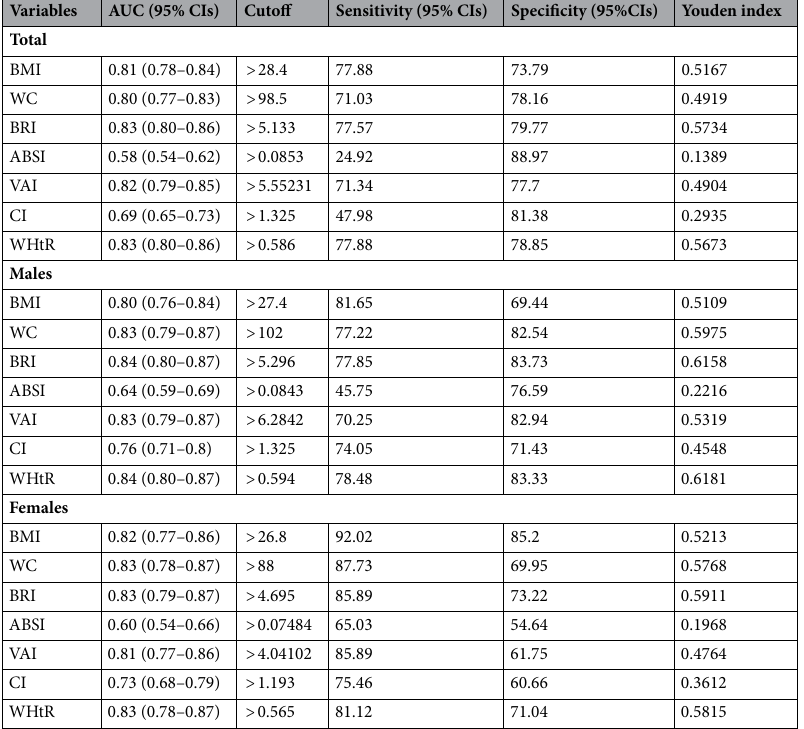
Table 4. Area under ROC curve (AUC), optimal cutoff values, sensitivities, specificities, and Youden index of anthropometric indices in predicting MSyn. Discriminatory power of the anthropometric indices as classifiers for MSyn presence was determined by ROC curve. AUCs and the 95%CI were used to compare the discriminatory power of each index. Sensitivity was defined as the percentage of true positive scores according to the MSyn presence. Specificity was defined as the proportion of scores identified incorrectly. Optimal cutoff points for all seven obesity indicators were determined with Youden’s J (J max. = Sensitivity + Specificity– 1) ROC Receiver operative characteristic curve, AUC area under the curve, CIs confidence intervals, MSyn Metabolic Syndrome, BMI body mass index, WC waist circumference, BRI body roundness index, ABSI a body shape index, VAI Visceral Adiposity Index, CI conicity index, WHtR Waist-to-height